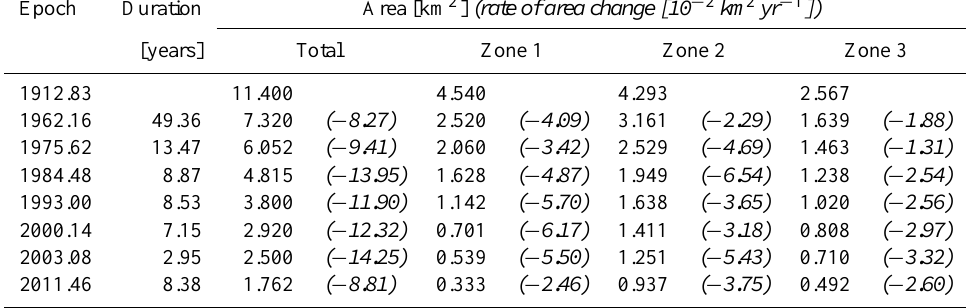
Table 2. Areal extents (km 2 ) of the total ice bodies between 1912 and 2011, as well as for zone 1 (western region), zone 2 (plateau region) and zone 3 (southern region) as defined in the text and Fig. 4. The annual rates of area change per observation period (10 − 2 km 2 yr − 1 ) are shown in parentheses for the total and zoned